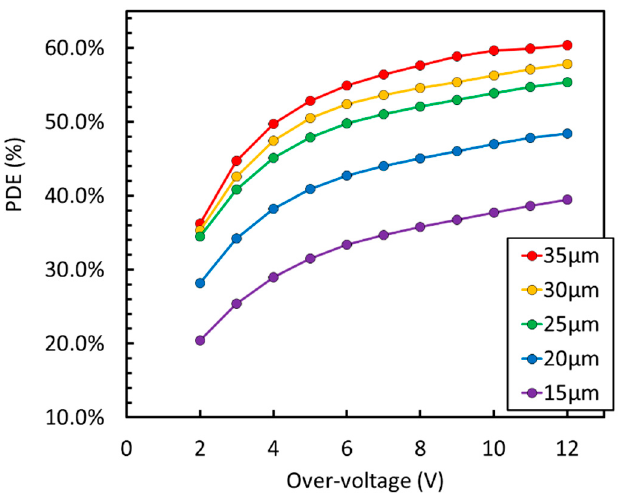
Figure 4. PDE at 420 nm as a function of the OV measured on different cell sizes of the NUV-HD silicon photomultiplier (SiPM) technology.